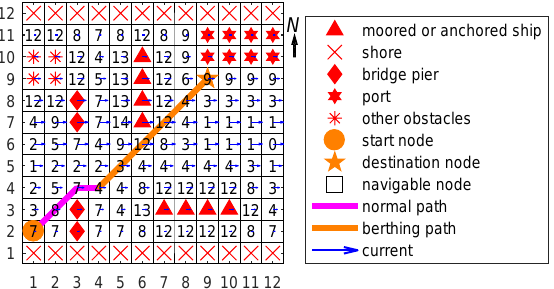
Figure 4. The berthing path generated by traditional A-Star algorithm.